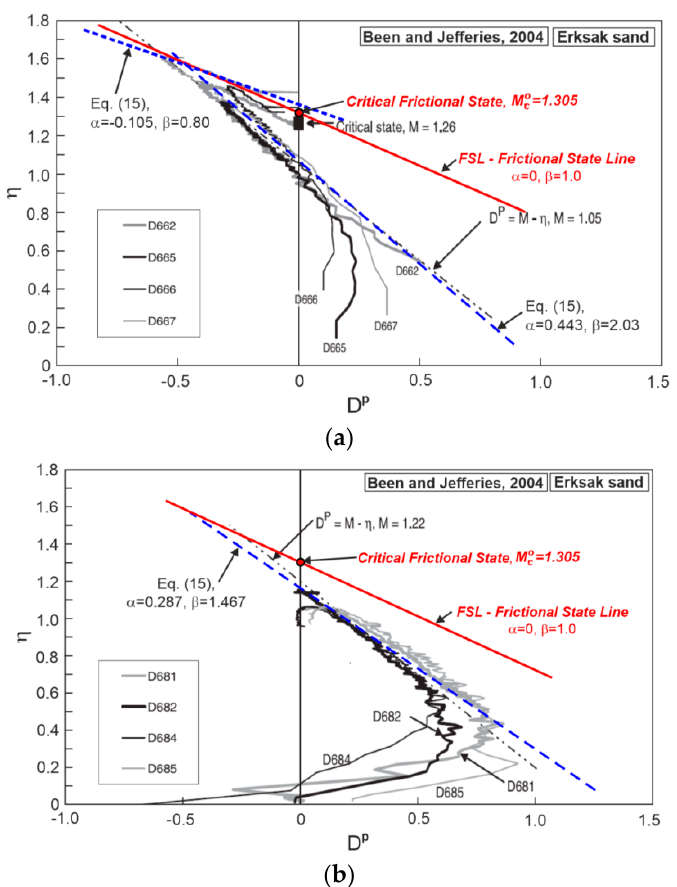
Figure 6. The relationships between the stress ratio and plastic dilatancy obtained by Been and Jefferies: ( a ) for dilative behavior; ( b ) for contractive behavior (adapted from [24]).